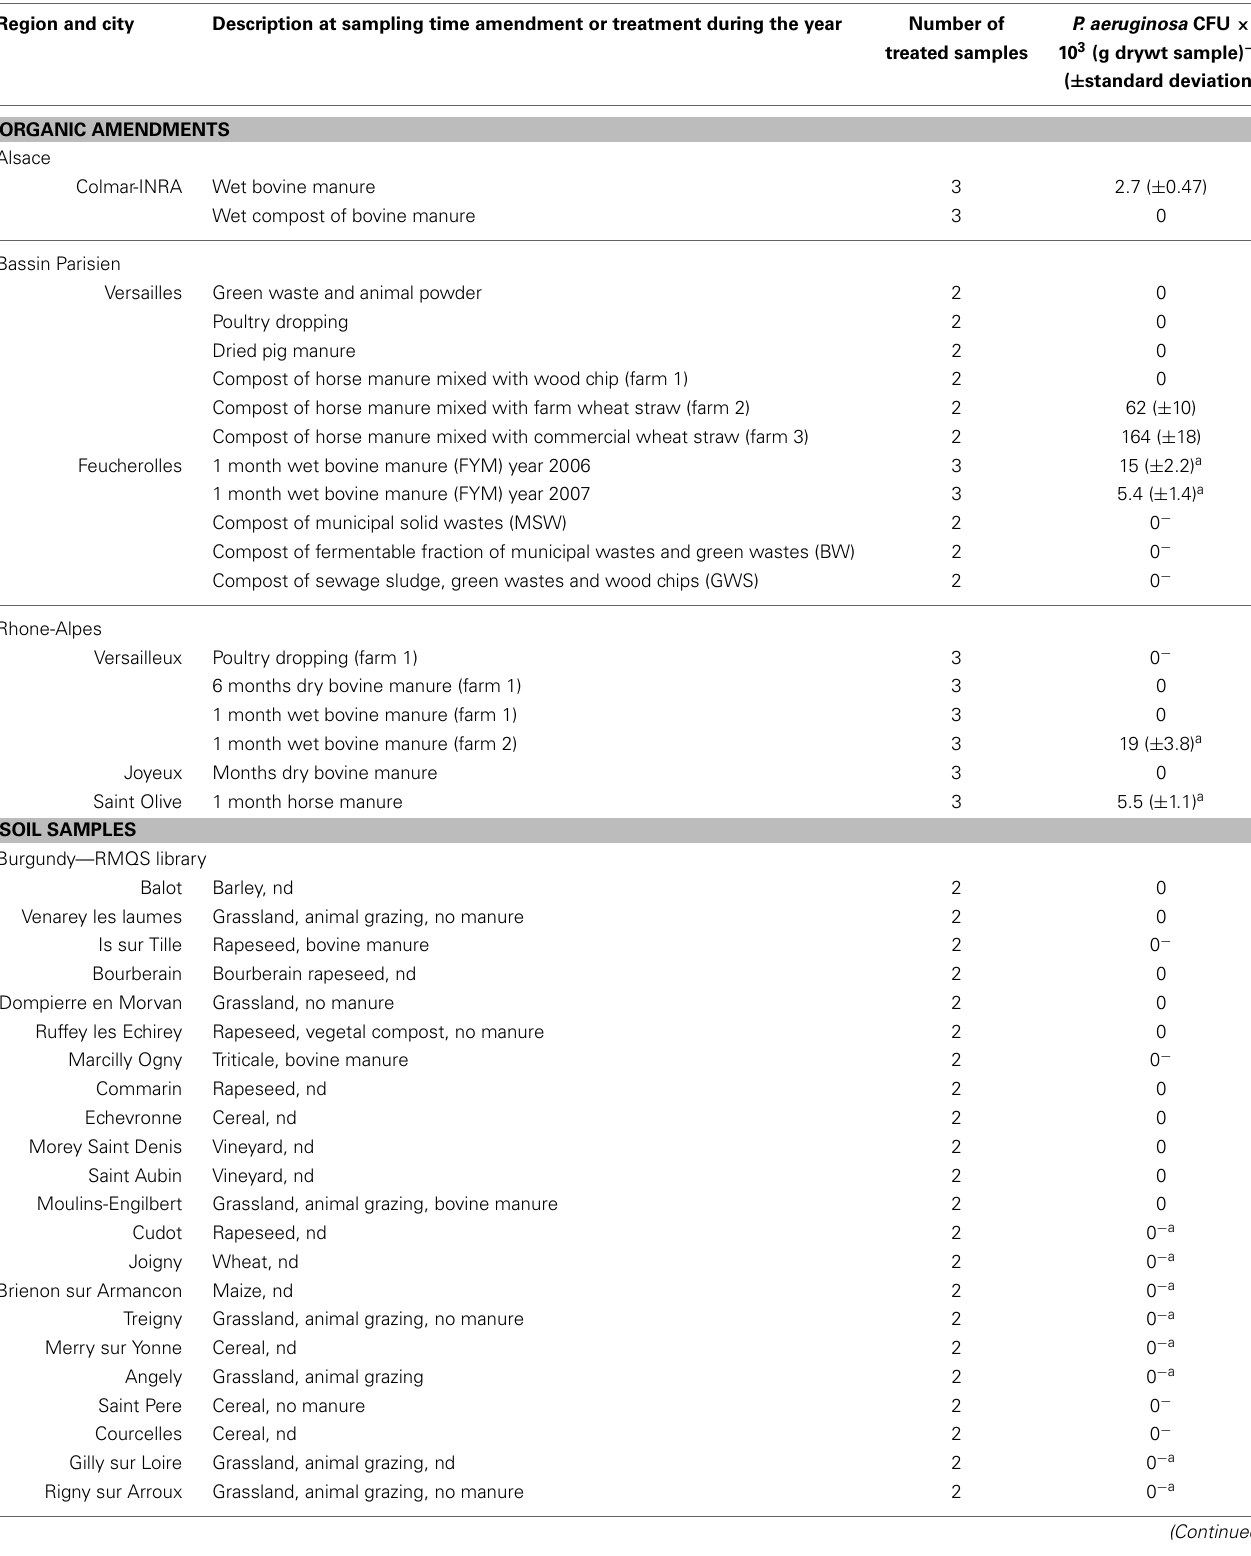
Table 1 | Number of CFU (colony forming units) of P. aeruginosa in organic amendments and agricultural soils amended or not with organic